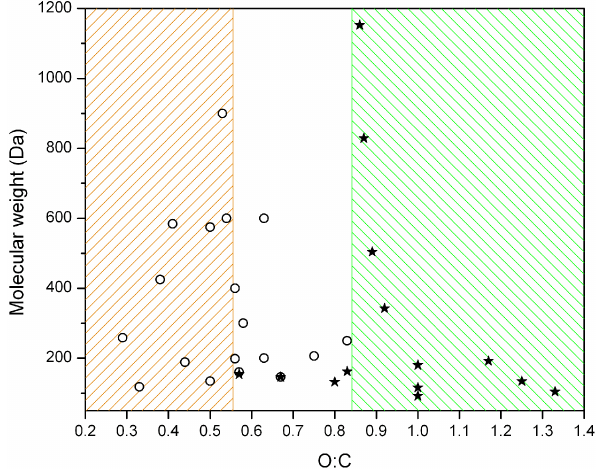
Figure 1. The effect of molecular weight and O:C of the organic species on the occurrence of liquid–liquid phase separation in mixed organic–ammonium sulfate particles (OIR = 2.0 ± 0.1). Data plot- ted are from the current study and You et al. (2013) and are sum- marized in Table 3. Open circles indicate liquid–liquid phase sepa- ration was observed, while stars indicate liquid–liquid phase sepa- ration was not observed. The orange-hatched region corresponds to the molecular weight and O:C of the organic species when liquid– liquid phase separation was always observed, and the green-hatched region corresponds to the molecular weight and O:C of the organic species when liquid–liquid phase separation was never observed.